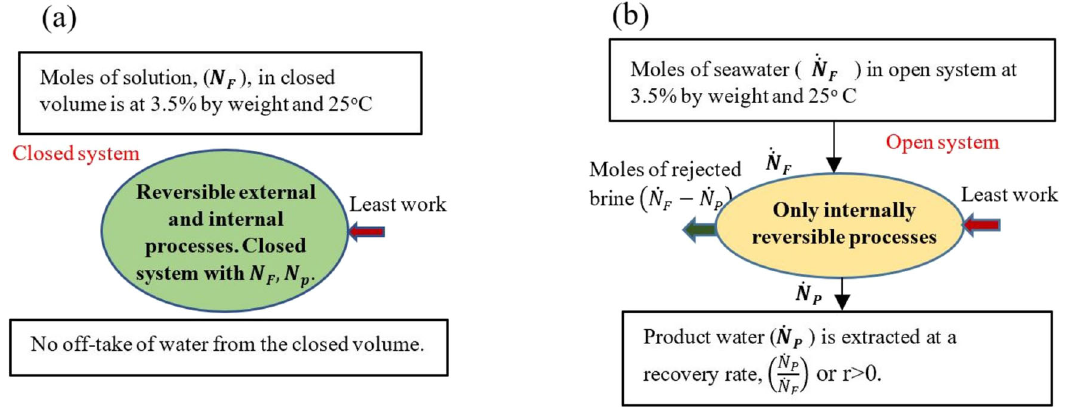
Fig. 5 Thermodynamic limits. a Universal, b Endoreversible.